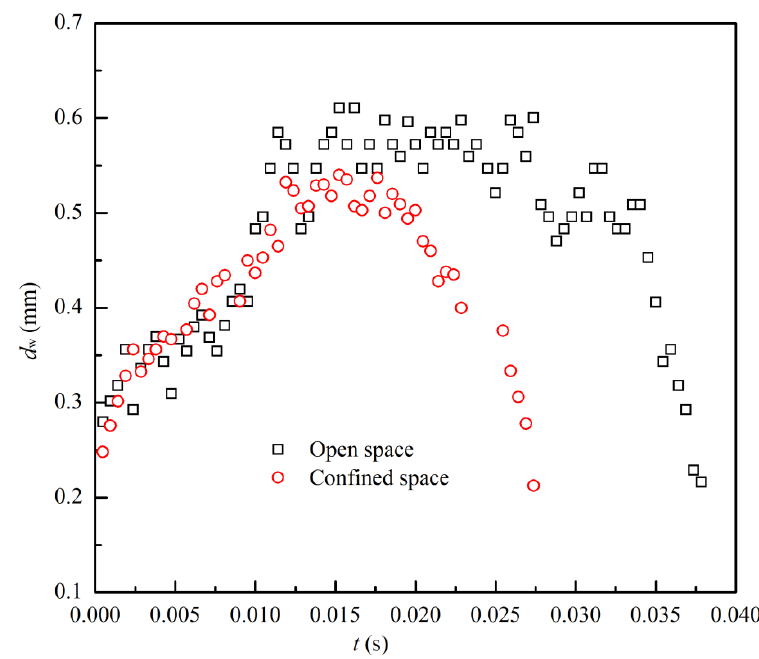
Figure 11. Comparison of bubble base diameter between restricted space and open space.